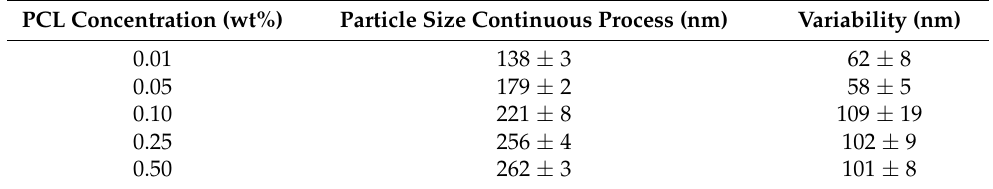
Table 2. Particle sizes produced by a continuous process (Y-mixer—flow rate 2 mL:8